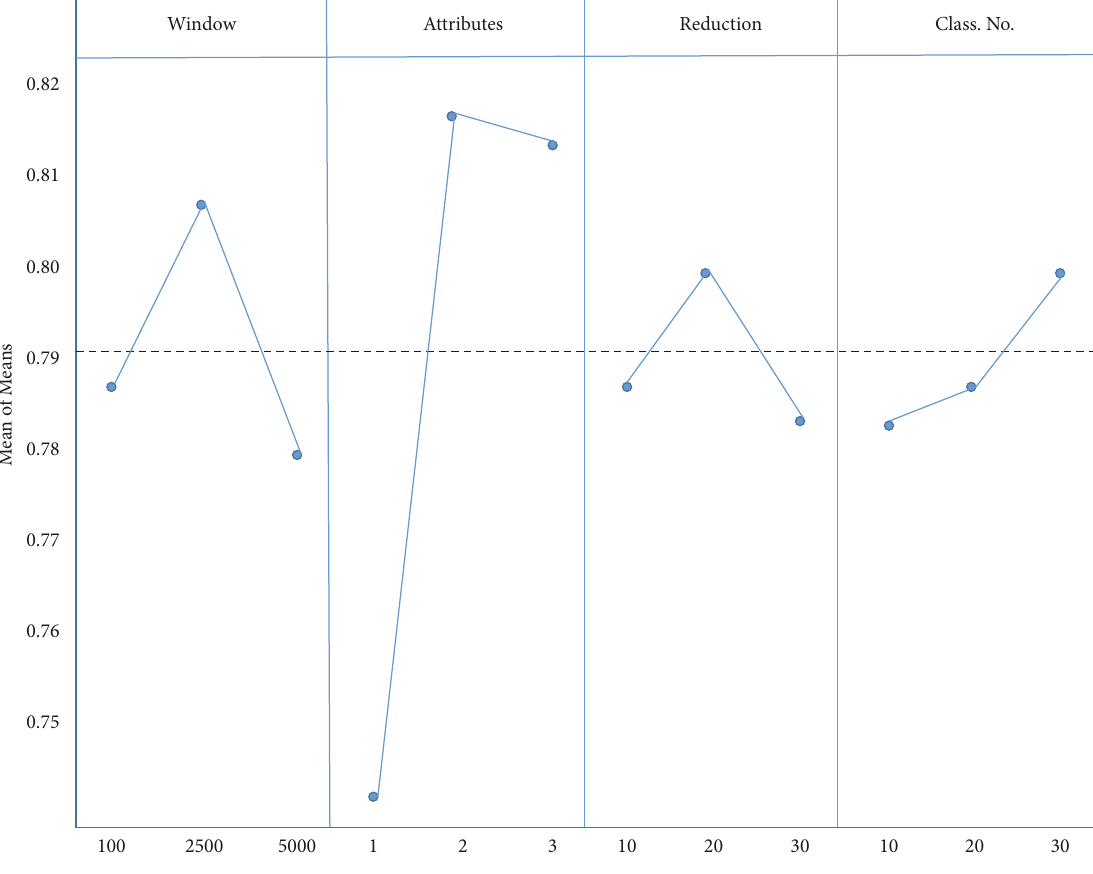
Figure 3: Main effects plot for classification accuracy means: Sea dataset.